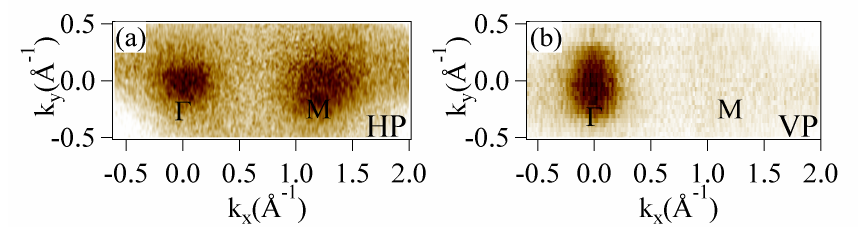
Figure 5. ARPES measurements of a 28-uc FeSe film deposited at d = 6.8 cm on CaF 2 measured with a photon energy of 85 eV at 45 K. ARPES maps measured with ( a ) HP ( b ) VP of the light,